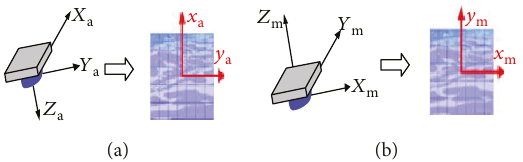
Figure 14: Image system when using the (a) aeronautical system and when using the (b) photogrammetric system.